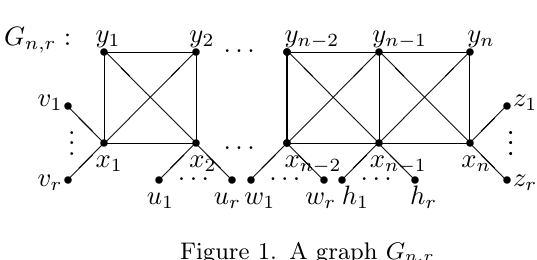
Figure 1. A graph G